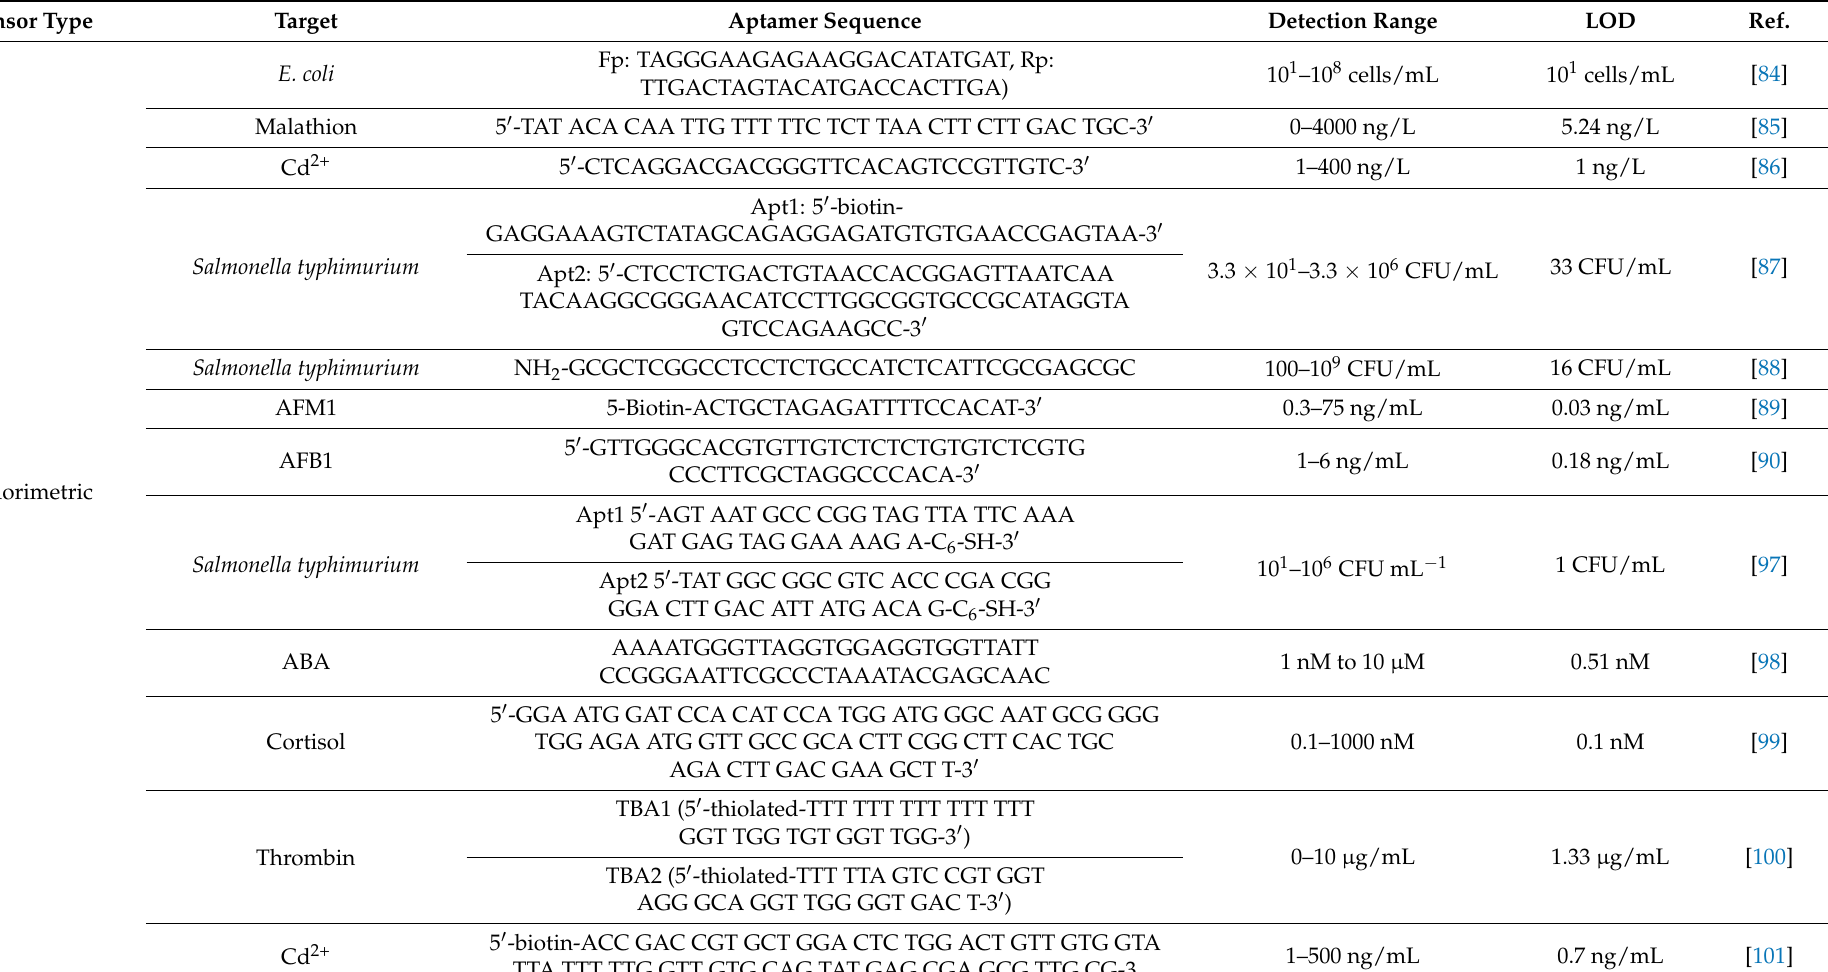
Table 1. Examples of application of aptasensors for quantitative